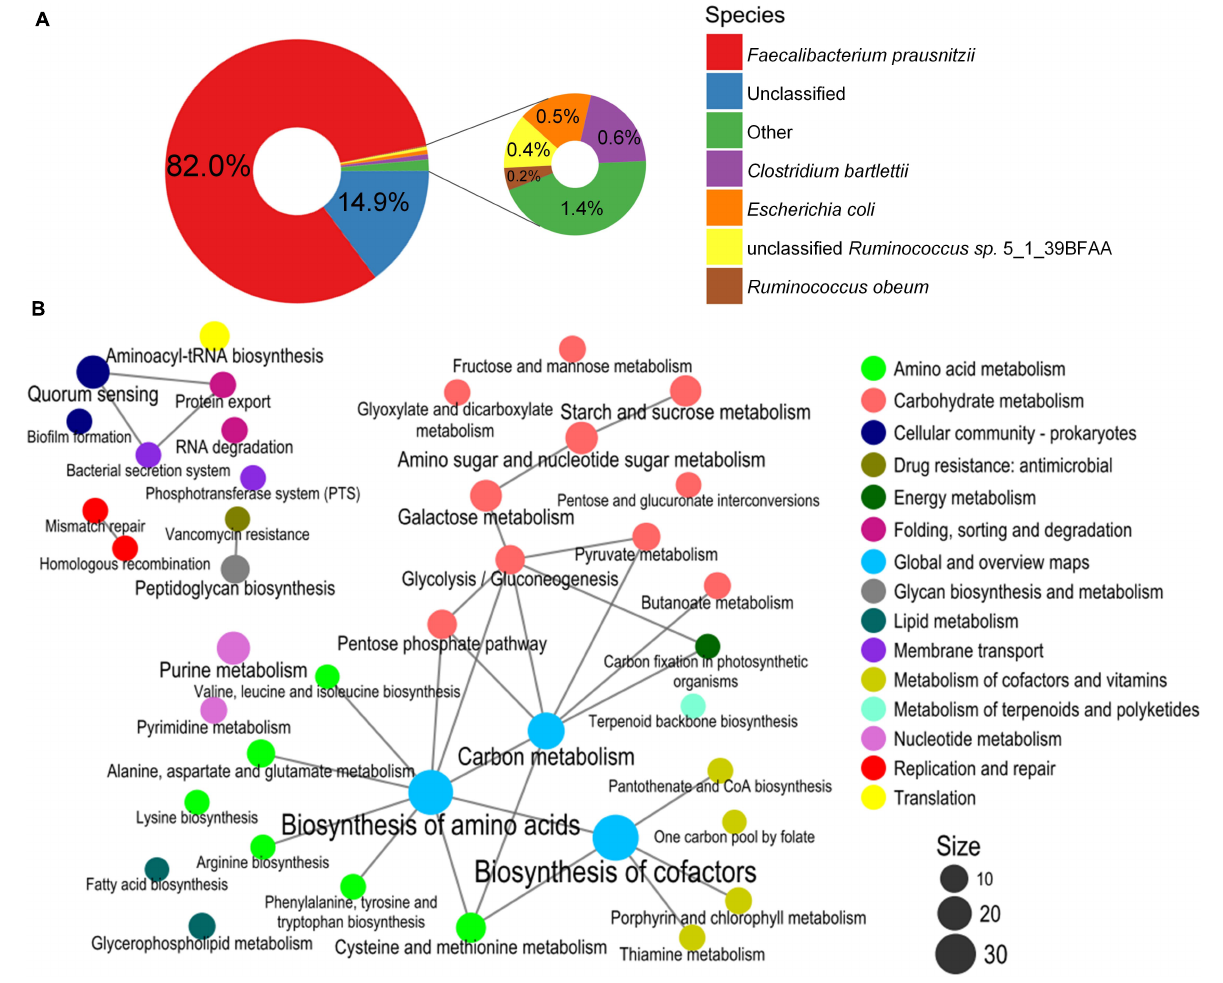
FIGURE 4 | Species composition and enrichment metabolic pathways carrying the BiasSNPs in PWS children. (A) Composition of species with BiasSNP in PWS children. Colors represent different species. (B) The relationship between the metabolic pathways of BiasSNP in PWS children. The line indicates that the metabolic pathways share the same gene, the dot represents the pathway, the size of the dot represents the number of genes with BiasSNP in the pathway, and the color represents the class of